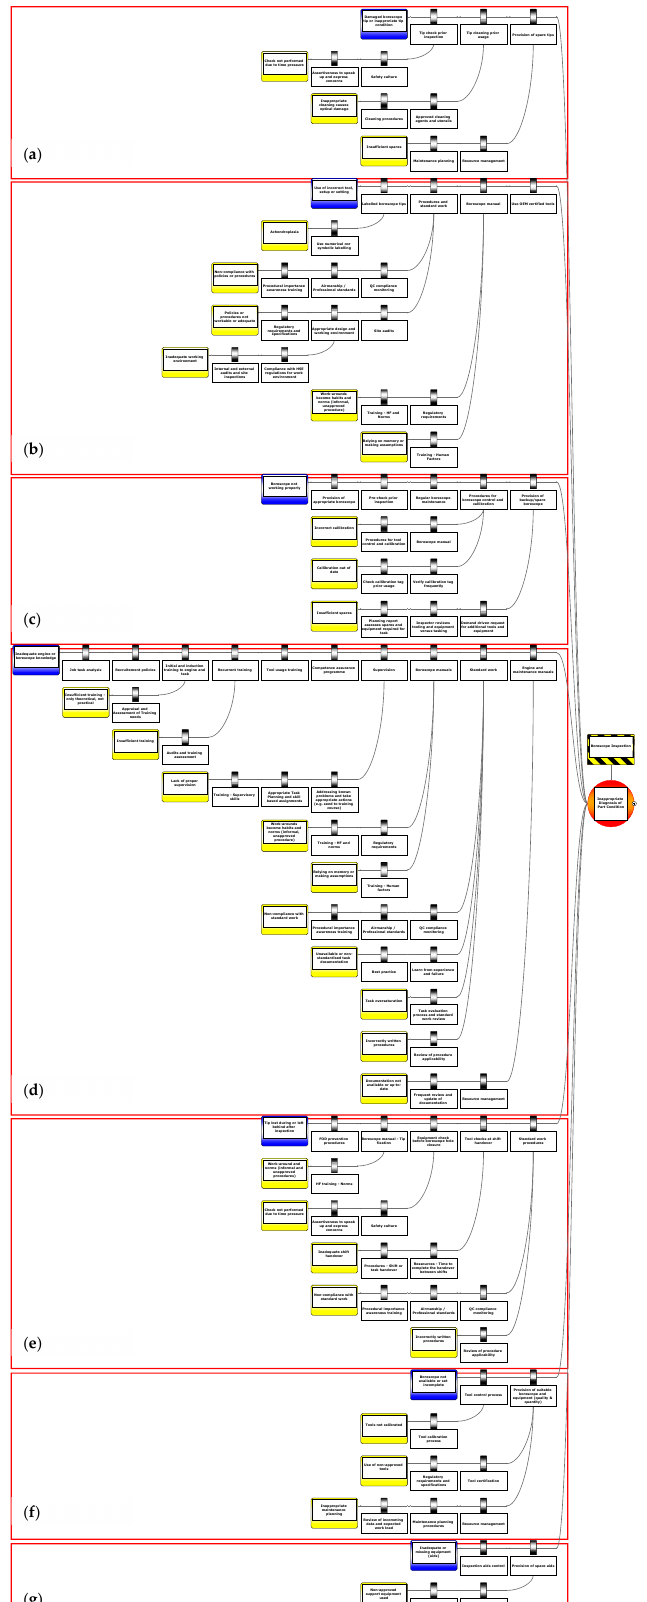
Figure A2. Threat side of the Bowtie diagram with prevention barriers, escalation factors, and escalation factor barriers.